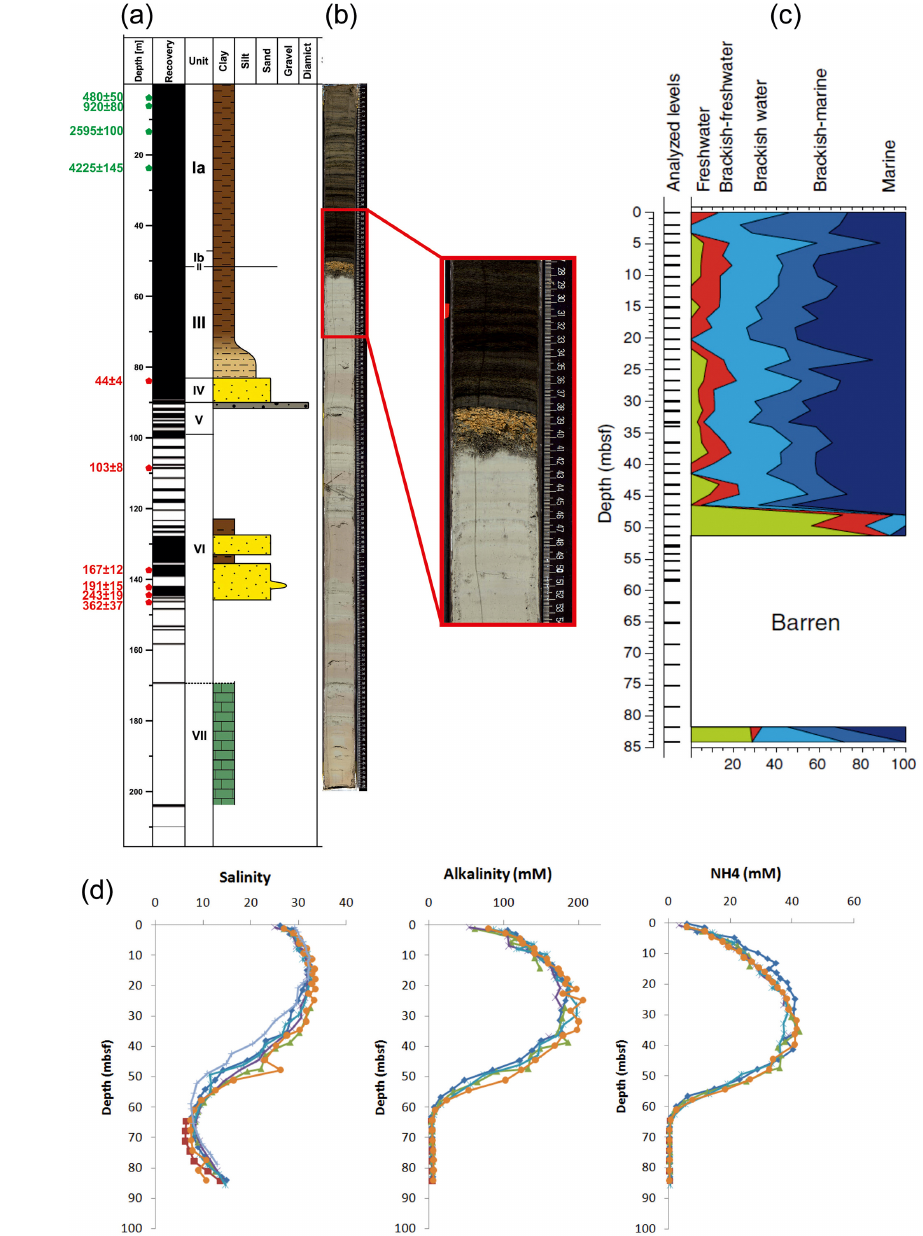
Figure 4. Little Belt, site M0059. (a) Lithostratography with ages: green is ages derived from 14 C dating given in calyrBP and red is ages derived from OSL dating given in kyBP. (b) Section 347-M0059A-16H-2 from 52m b.s.f. shows the hiatus sand horizon of unit II at the transition from the varved clay sequence of Unit III into the laminated black organic-rich clay of subunit Ib. Inset: close-up of the coarse- grained, poorly sorted sand hiatus marking a low stand. (c) Relative distributions of diatom taxa according to their preferred habitat salinity. (d) Examples of interstitial water chemistry: diffraction-based salinity, alkalinity, and ammonium. Different symbols show data from different